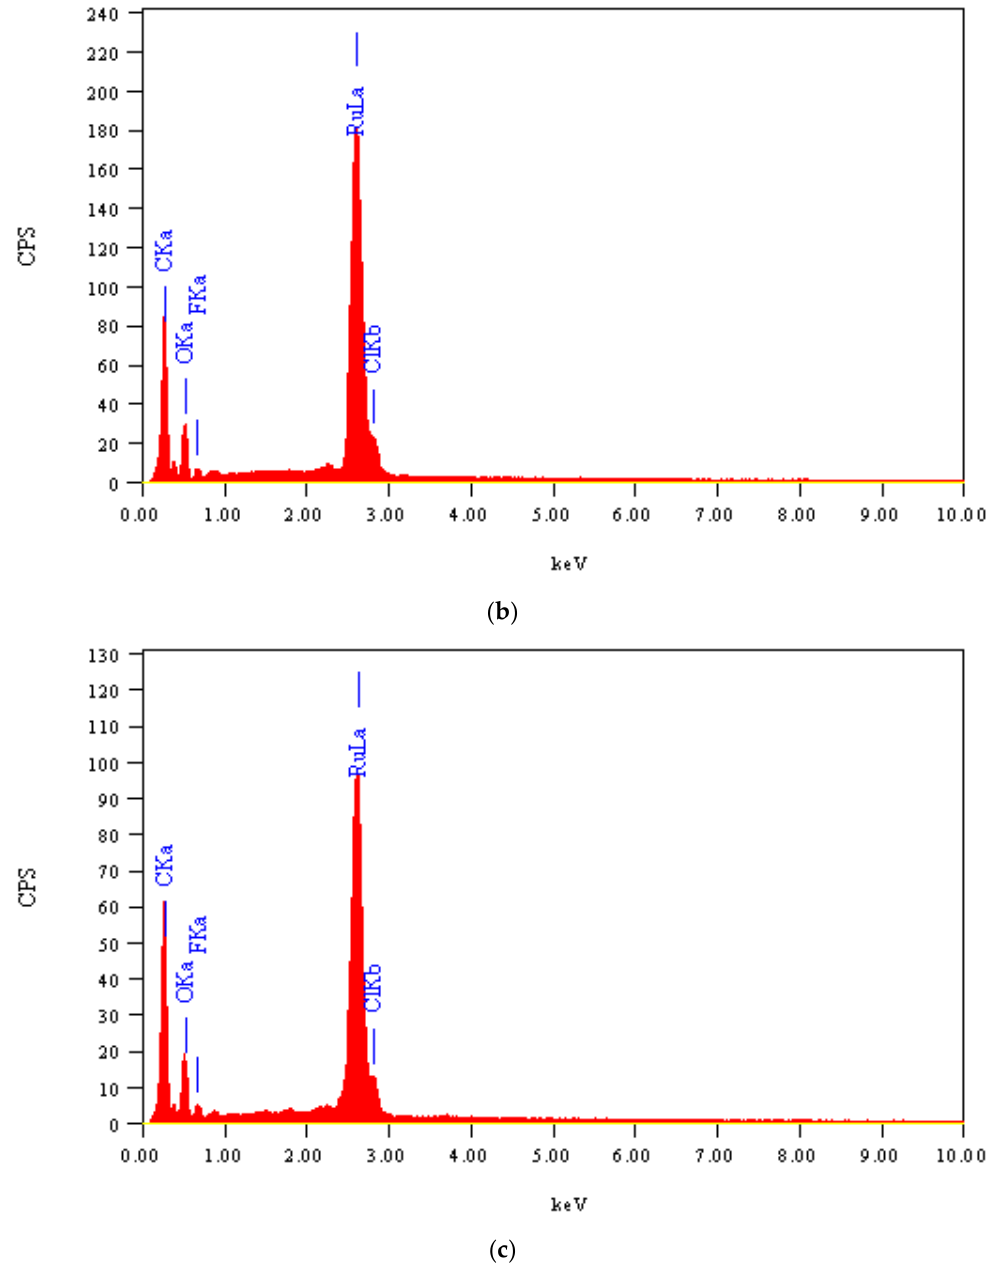
Figure 6. ( a ) EDX spectrum of Complex 1 ; ( b ) EDX spectrum of Complex 2 ; ( c ) EDX spectrum of Complex 3 .